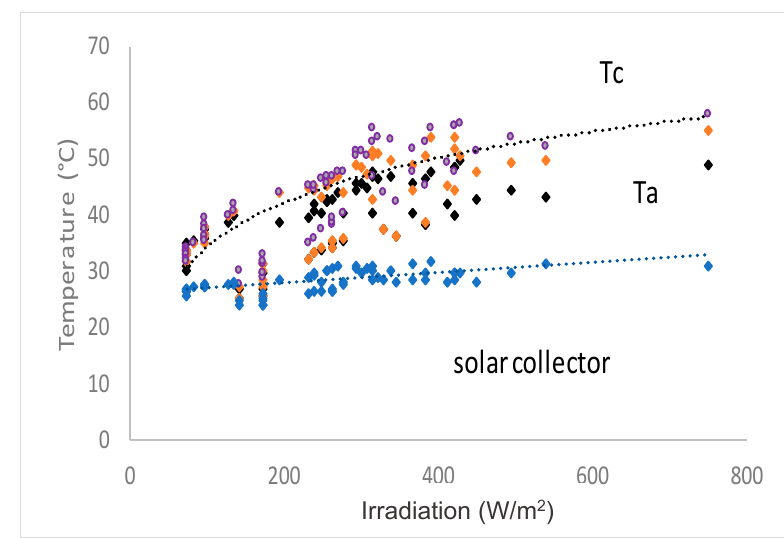
Figure 5. Measurements performed under environmental conditions for the solar collector,